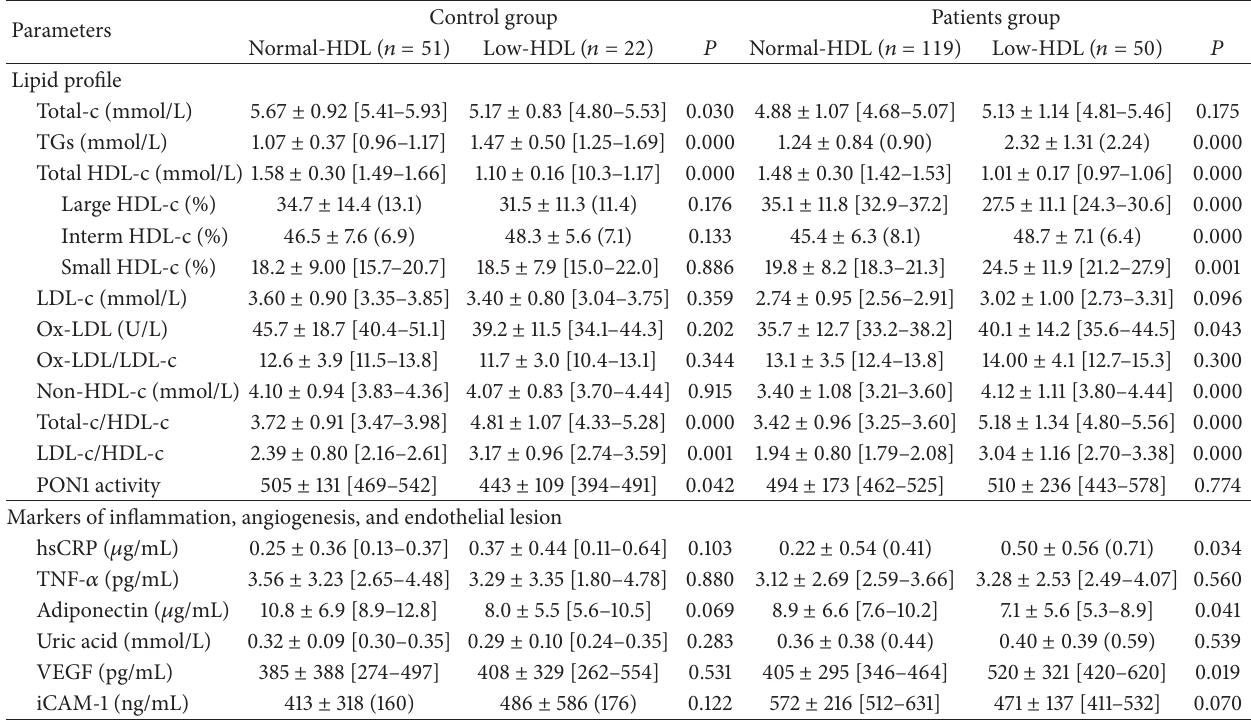
Table 2: Lipid profile and markers of inflammation, angiogenesis, and endothelial lesion of the study